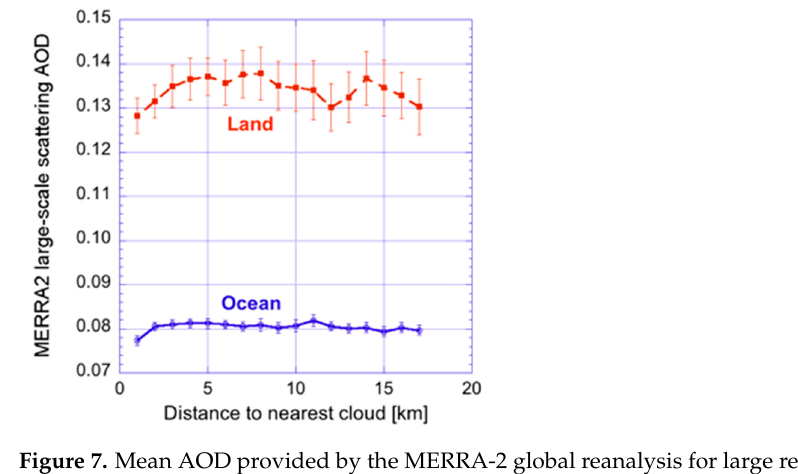
Figure 7. Mean AOD provided by the MERRA-2 global reanalysis for large regions that surround points located at certain distances from nearby clouds. See text for details. (Data used are available at Table S10).